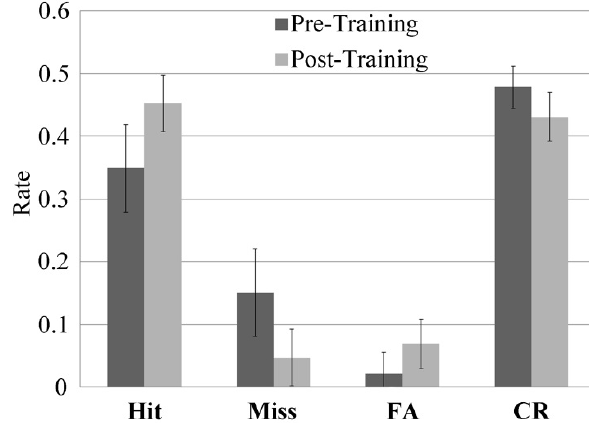
Figure 4 – The mean rates ± SD for all classifications. All classifications were significantly different following training.